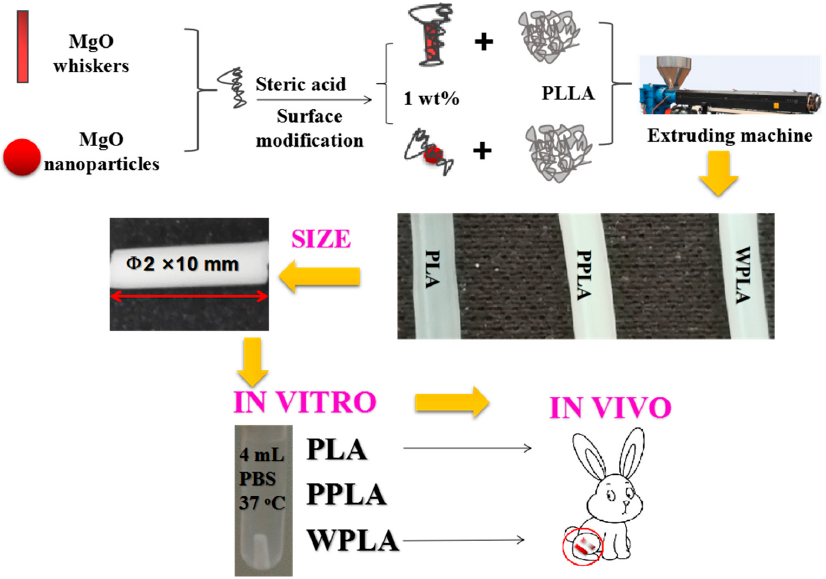
Figure 1. Schematic illustration of the experiment.